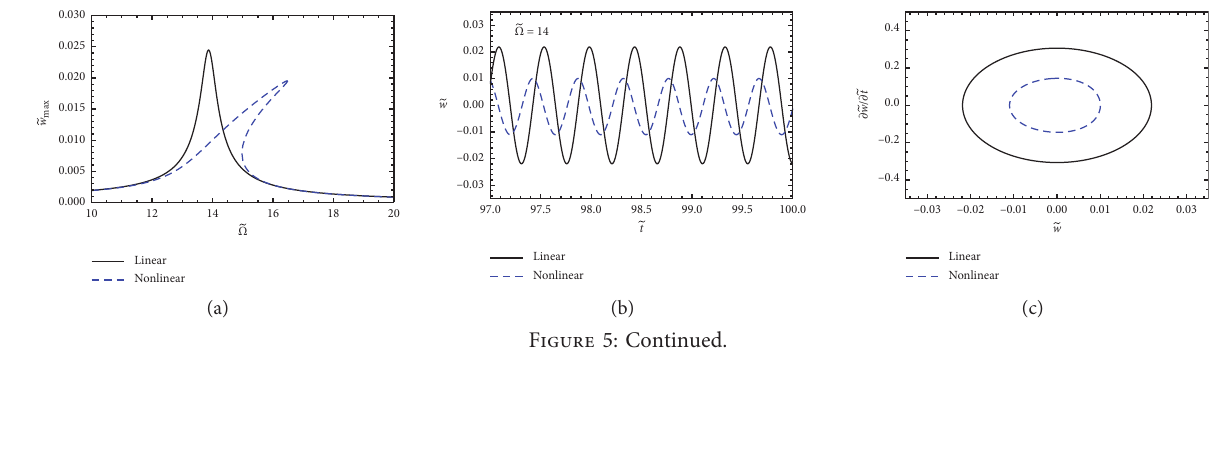
Figure 4: Frequency-response of the coupled vibration of SS BDFG porous beam when m (a), (b) Maximum and minimum amplitudes of transverse vibration. (c) Maximum amplitudes of longitudinal vibration. (d) Maximum amplitudes of rotational